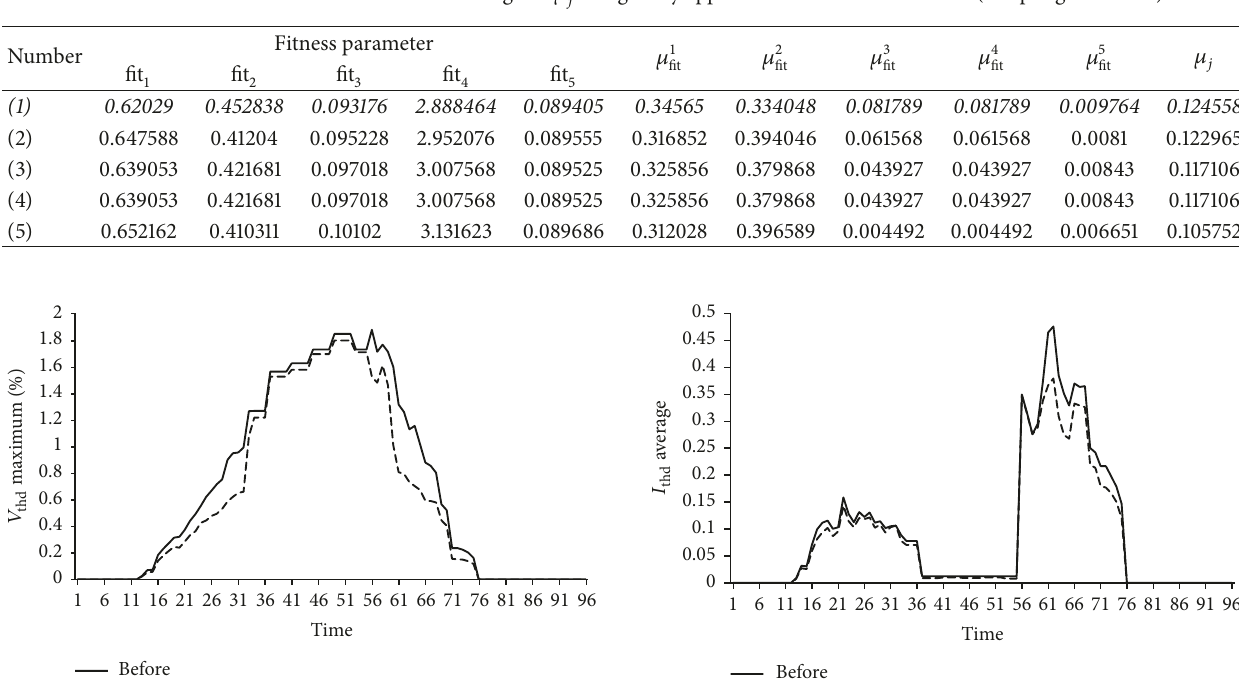
Table 7: The five best solutions based on the highest 𝜇 𝑗 using fuzzy approach for 10 sets of solutions (sampling time = 30).